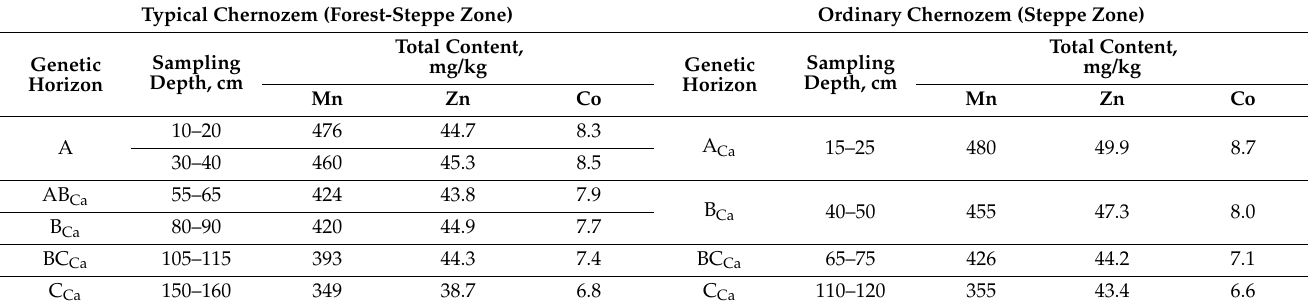
Table 4. Average gross trace elements in soil profiles of reserved typical and ordinary chernozems,